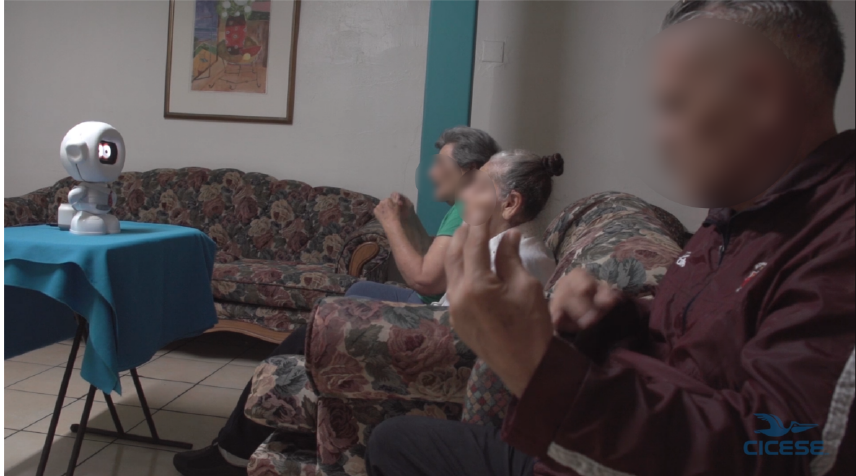
Figure 1. A therapeutic session with three participants conducted by the robot